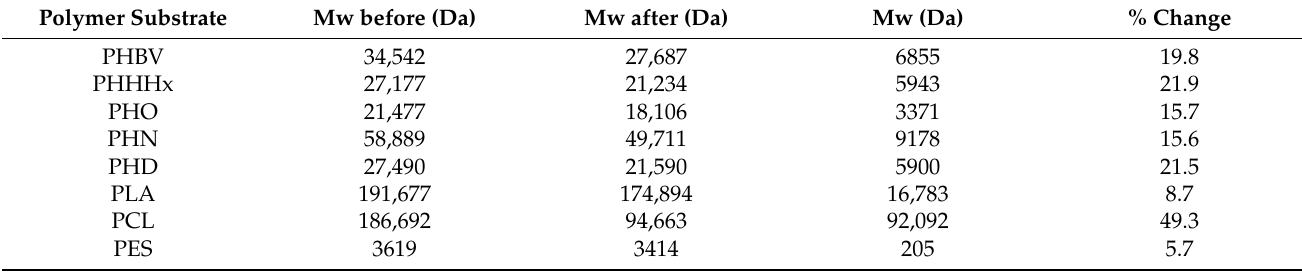
Table 5. Percent decrease in polymer molecular weight after treatment with LIP4.